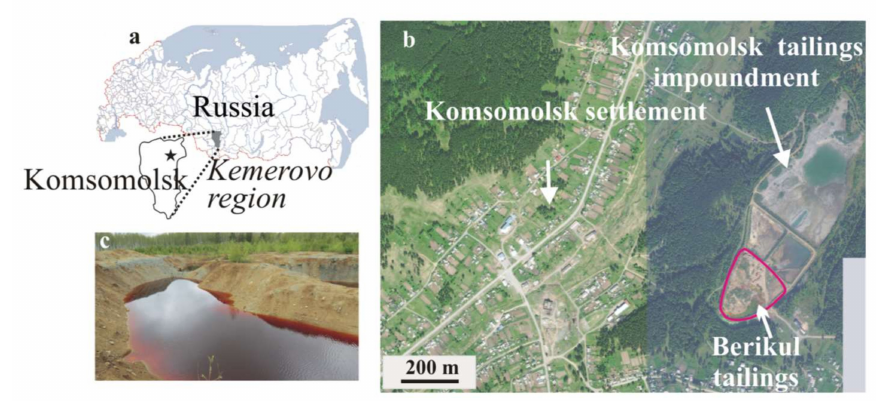
Figure 1. ( a ) Geographic position; ( b ) sample site at the Berikul tailings; and ( c ) photograph of acid